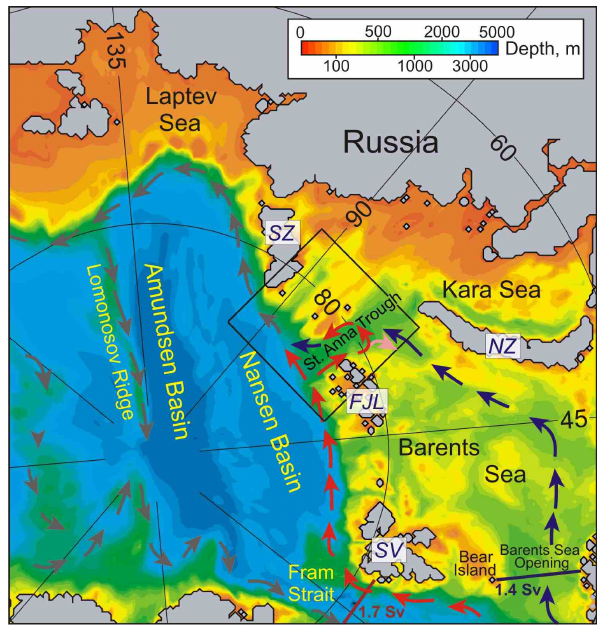
Figure 1. Map of the inflow region of Atlantic water (AW) to the Arctic Ocean. Arrows trace the Atlantic water (AW) pathways; red and blue arrows show the Fram Strait and Barents Sea branches, respectively, of the AW inflow into the Arctic Ocean in accordance with Rudels et al. (1994). The pink arrow shows a fraction of the Fram Strait branch water flowing west along the shallower trough between Novaya Zemlya and Franz Josef Land. Dark red and blue numbered lines in Fram Strait and Barents Sea Opening, respec- tively, show sections used for verifying the simulated volume trans- port of AW. Dark blue number indicates the simulated volume trans- port of AW (defined as T >3 ◦ C) through the Barents Sea Opening. Dark red number shows the simulated volume transport of AW (de- fined as T >2 ◦ C) in the core of the West Spitsbergen Current. The black rectangle encloses the region enlarged in Fig. 2. SV – Sval- bard, FJL – Franz Josef Land, NZ – Novaya Zemlya, SZ – Sever- naya